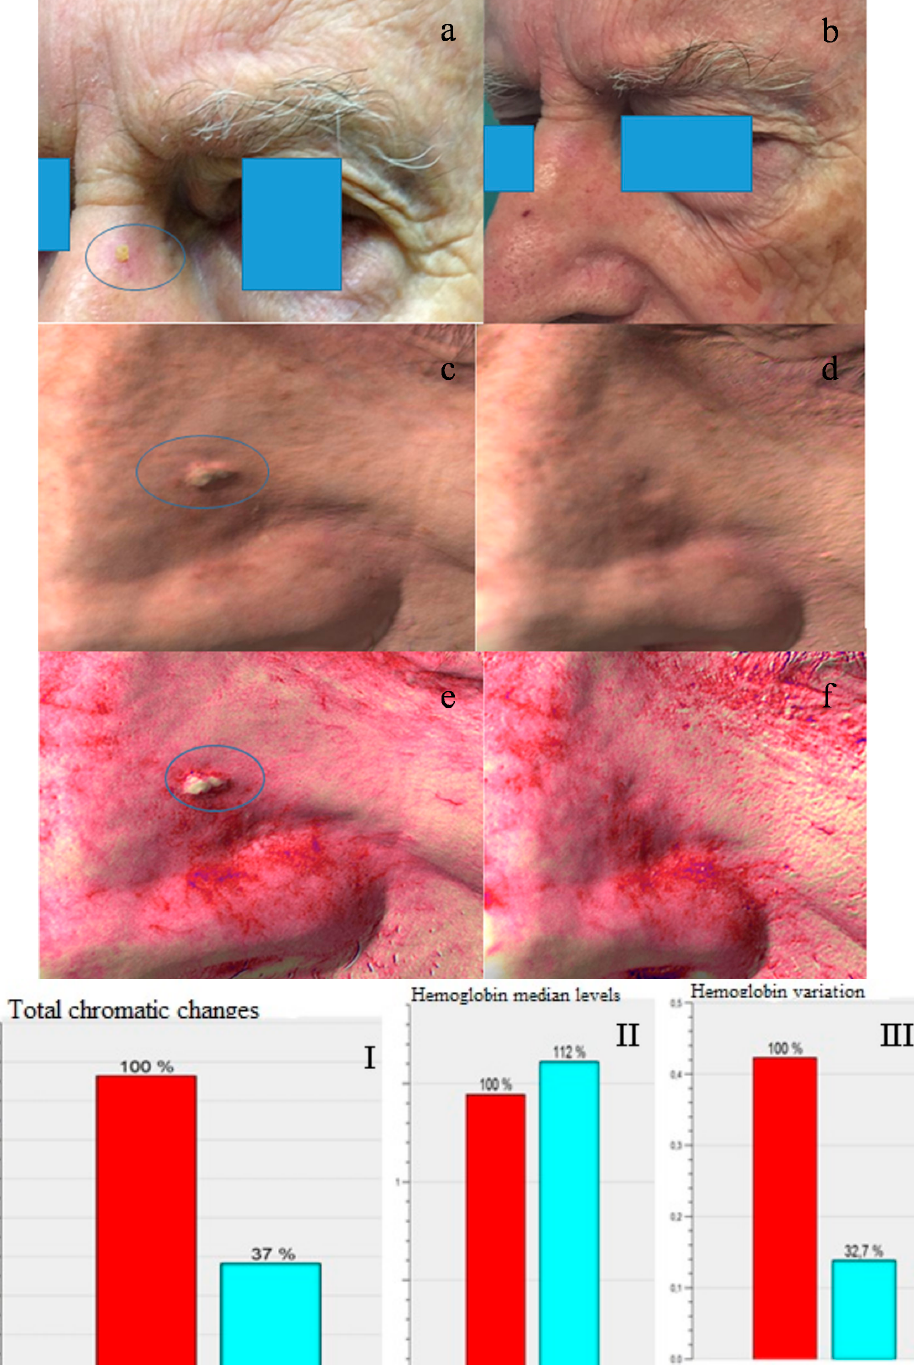
Figure 2. ( a ) Macroscopic picture of KINII AK on the later left side of the nose; ( b ) Complete healing after one MAL-DL-PDT treatment (follow-up after three months); ( c , d ) Antera three-dimensional pictures before and after one treatment; ( e , f ) Hemoglobin concentration reduction after one treatment; ( I ) The graphs show automated evaluation by Antera software of color and hemoglobin concentration before (red column) and after one treatment (blue column); ( II , III ) The graphs show the variation of median levels of hemoglobin before (red column) and after one treatment (blue column). Median level of hemoglobin means median levels of hemoglobin in the area of the lesion; hemoglobin variation means difference in hemoglobin levels before and after therapy.